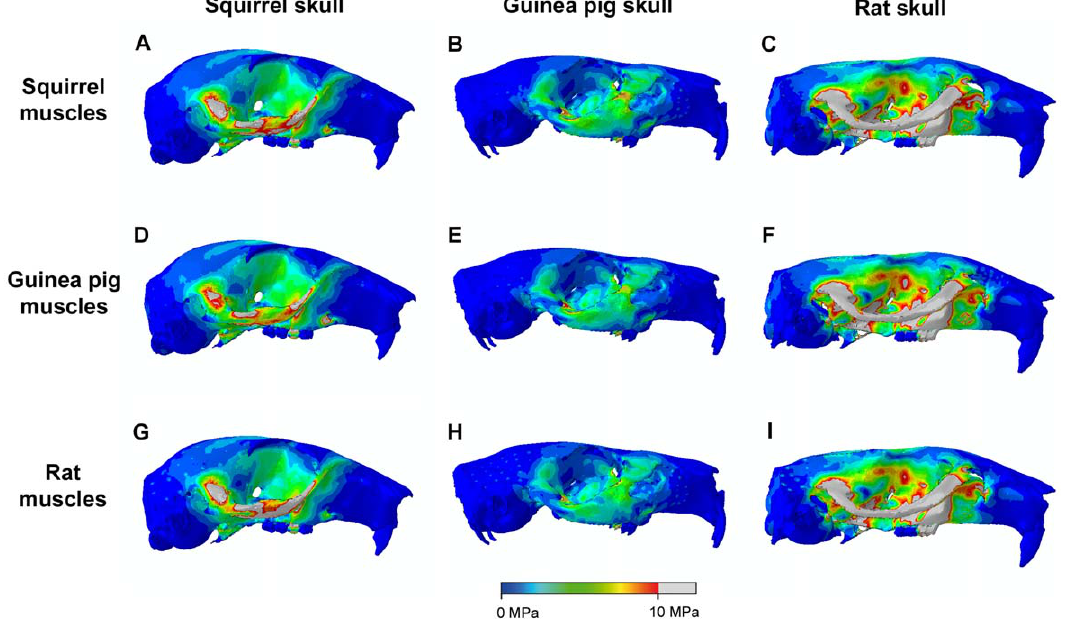
Figure 6. Predicted distribution of von Mises stresses across the skull. Unilateral biting on M1 in squirrel (A,D,G), guinea pig (B,E,H) and rat (C,F,I), each loaded with squirrel (A–C), guinea pig (D–F) and rat muscles (G–I). Grey areas indicate von Mises stresses exceeding 10 MPa.